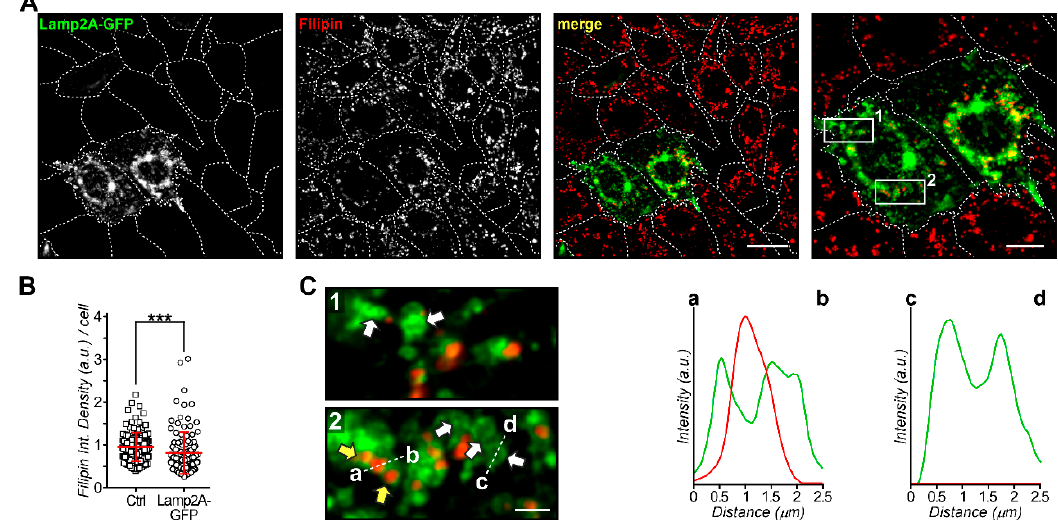
Figure 4. Lamp2A-GFP overexpression reduces late endosomal cholesterol (LE-Chol) accumulation in NPC1 mutant cells. ( A ) CHO M12 cells were transfected with Lamp2A-GFP (green), fixed, and stained with filipin to visualize free cholesterol (red). A representative image, including the merged image, is shown (scale bar, 20 µ m; 10 µ m in enlarged right panel). The shape of all cells was outlined. ( B ) The fluorescence intensity of filipin staining (integrated density per cell) of at least 20 control (Ctrl) and Lamp2A-GFP transfected cells from three independent experiments was quantified and shown in a dot plot. The mean ± SEM is also given (*** p < 0.001). ( C ) Two enlarged regions of interest from A (1 and 2) show details of Lamp2A-GFP / filipin colocalization and vesicle heterogeneity in transfected cells (scale bar, 2 µ m). White arrows point at filipin-negative, but Lamp2A-positive vesicles (1,2) and yellow arrows highlight Lamp2A-positive vesicles colocalizing with filipin (2). Line profiles of fluorescence intensities of Lamp2A-GFP (green) and filipin (red) are shown (a–b and c–d, 2.5 µ m).